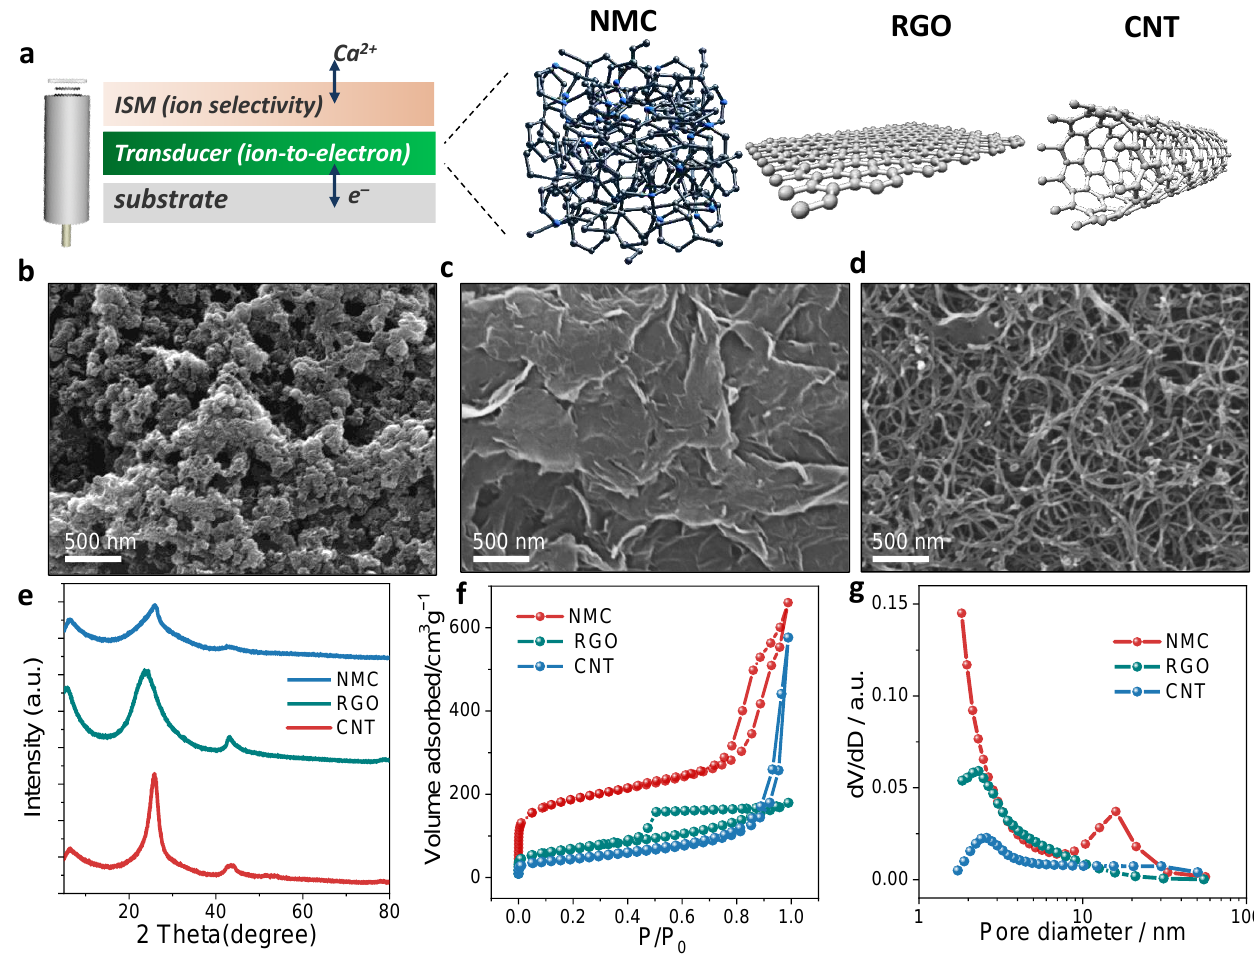
Figure 1. Carbon-based solid-contact ion-selective electrodes (SC-ISEs). ( a ) A schematic illustration of SC-ISEs based on SC materials of NMC, RGO and CNT. ( b – d ) SEM images of NMC, RGO and CNT. ( e ) XRD patterns for NMC, RGO and CNT. ( f ) N 2 adsorption/desorption isotherms and ( g ) Pore-size distributions of NMC, RGO and CNT.